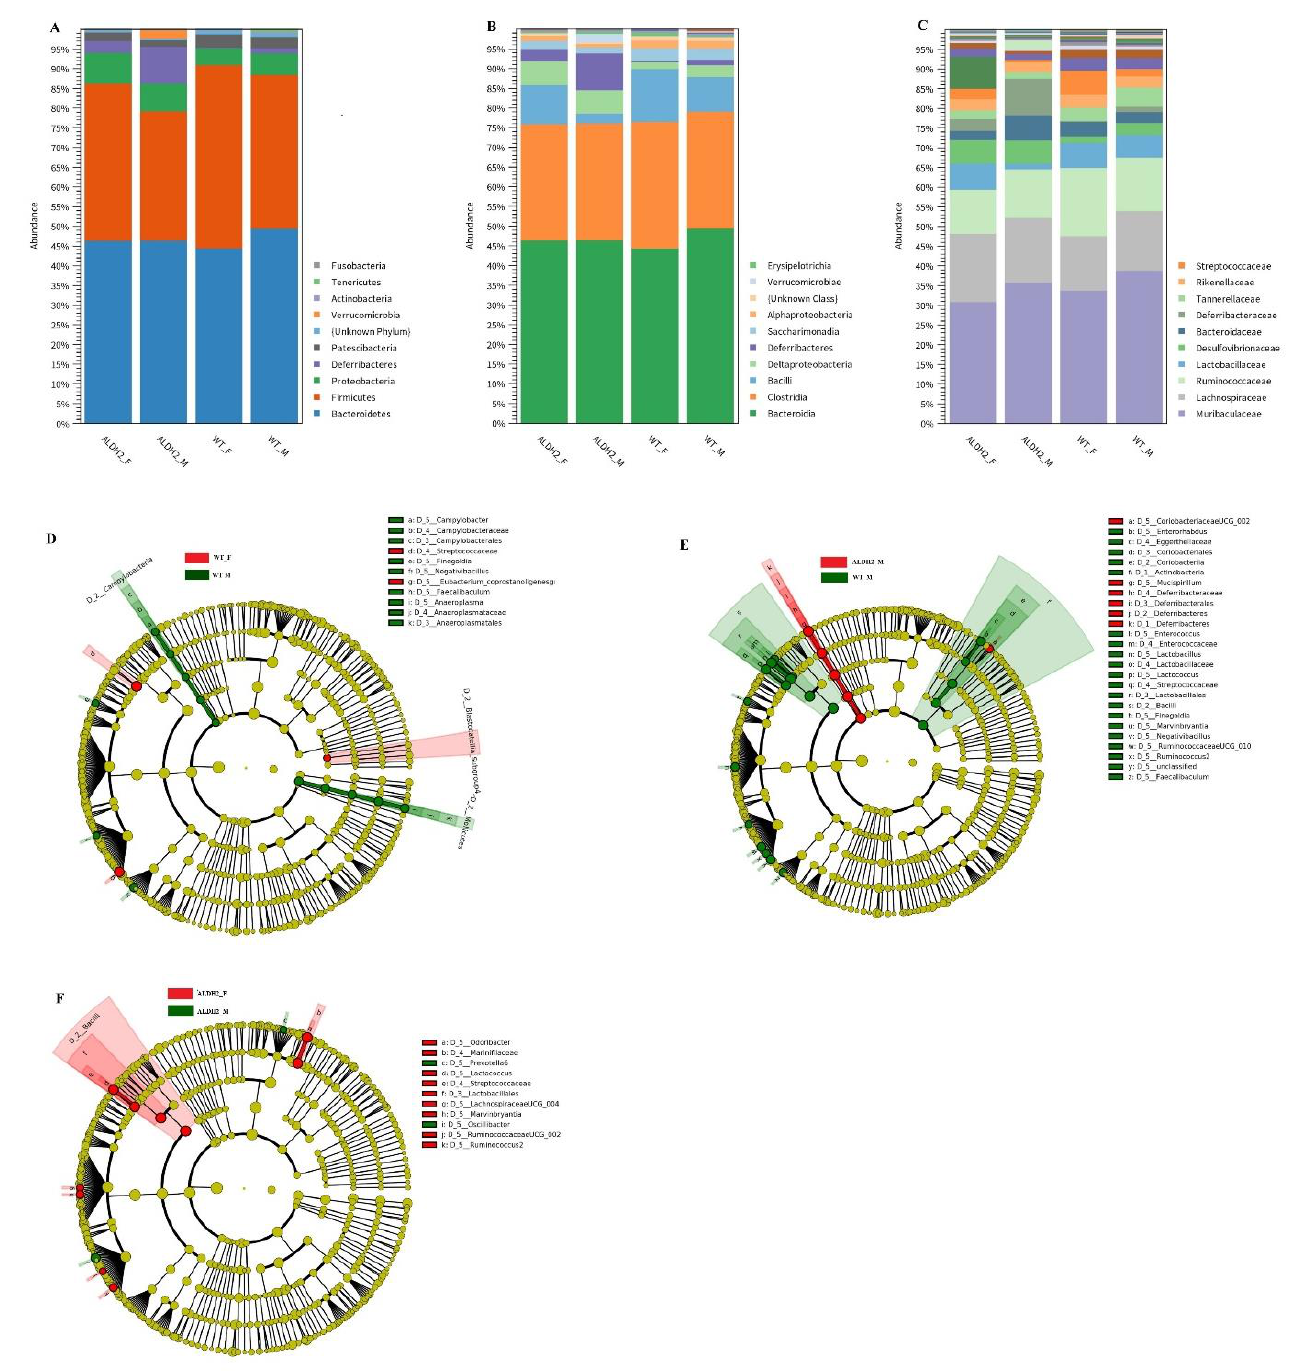
Figure 5. Gut-microbiota composition in wild-type (WT) and ALDH2 ( A ) phylum-level taxonomic distribution of microbial communities in fecal contents; ( B ) class-level taxonomic distribution of microbial communities in fecal contents; ( C ) order-level taxonomic distribution of microbial communities in fecal contents. Cladogram generated from LEfSe analysis showing most differentially abundant taxa enriched in microbiota between ( D ) WT-M and WT-F, ( E ) WT-M and ALDH2-M, and ( F ) ALHD2-M and ALDH2-F.